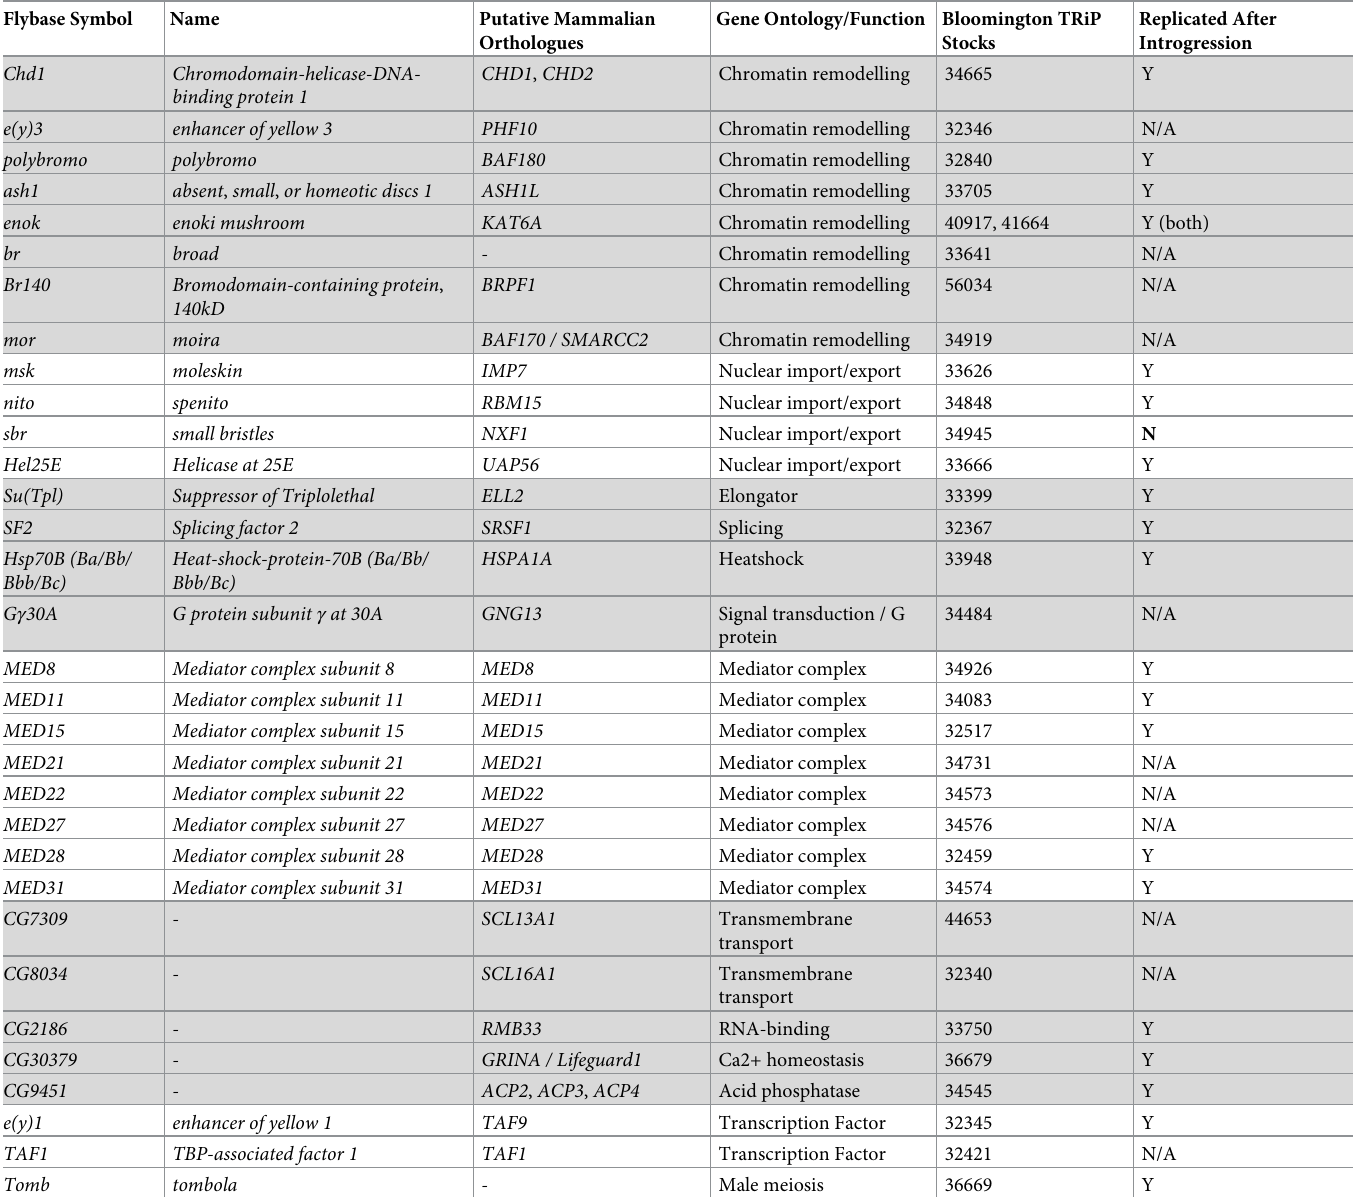
Table 1. List of genes targeted by TDP-43 toxicity rescuing shRNA lines. Flybase